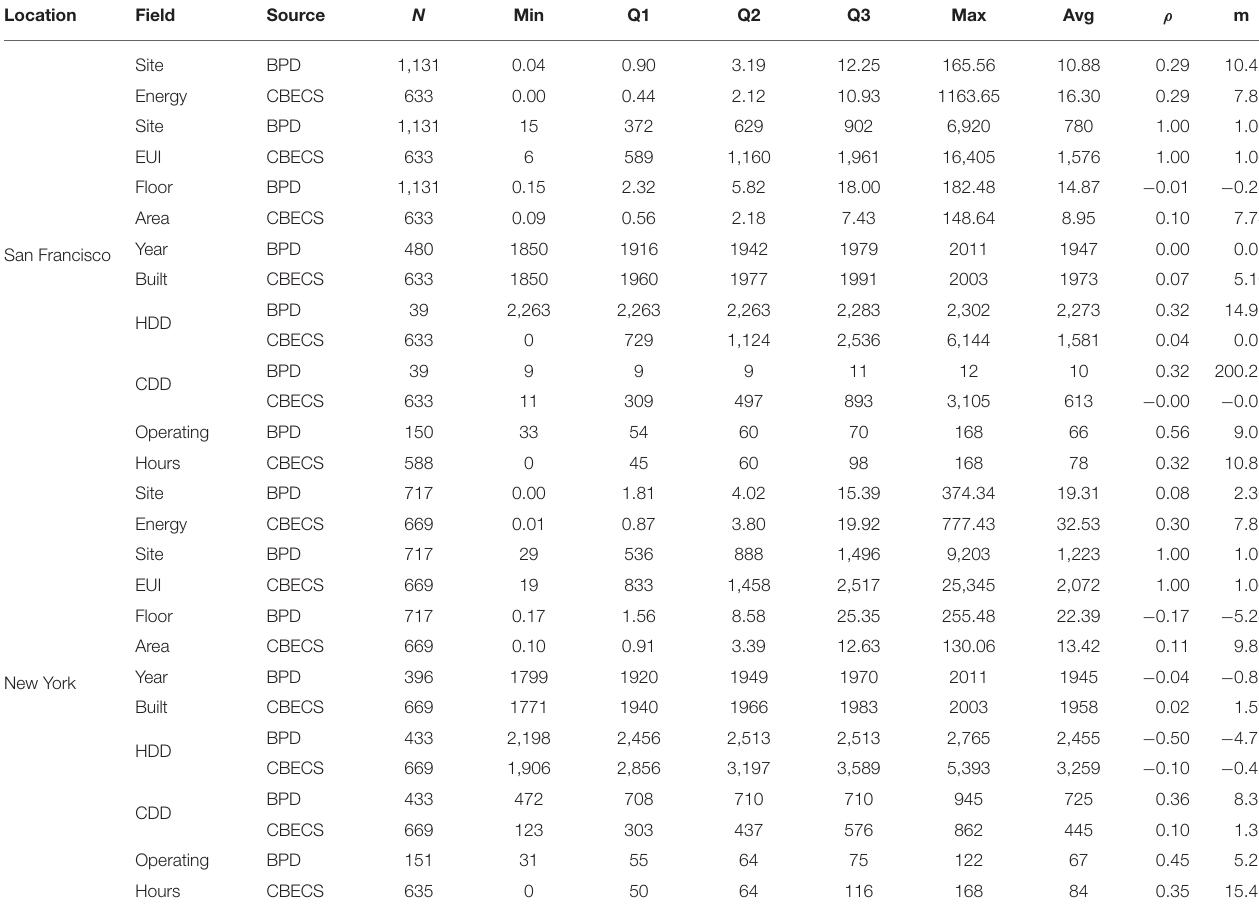
TABLE 3 | Table showing range and distribution of reported values in BPD and CBECS for office, education and retail buildings.